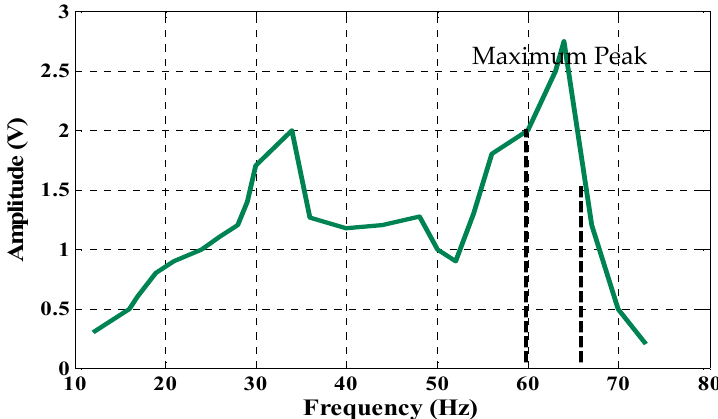
Figure 10. Frequency spectrum of the PVT.